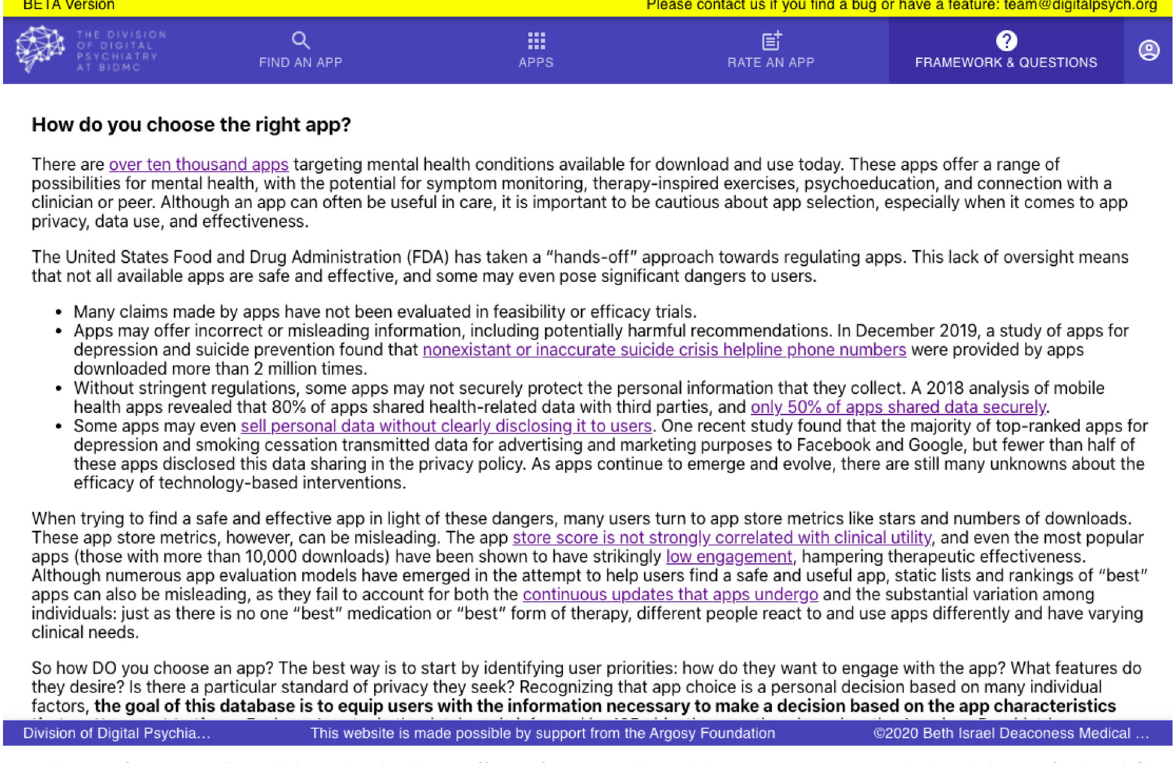
Fig. 5 Database Informational Modules. The database offers informational modules in conjunction with the ability to fi nd and fi lter